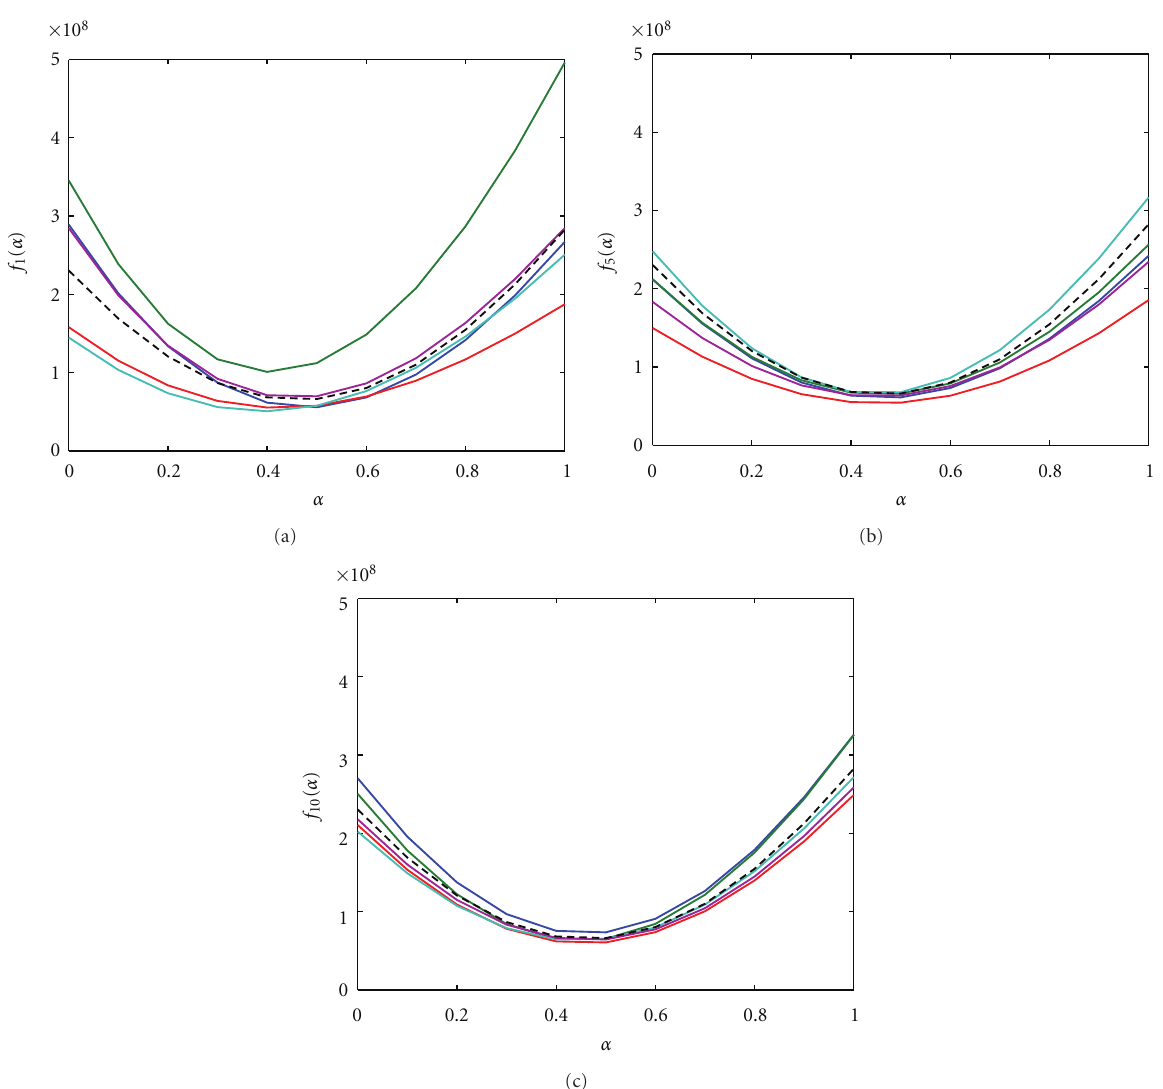
Figure 4: Behavior of misfit for various K . Shown are five di ff erent stochastic realizations and the true misfit (dashed line) for (a) K = 1, (b) K = 5, and (c) K = 10. The stochastic misfits approximate the true misfit fairly well for relatively small batch